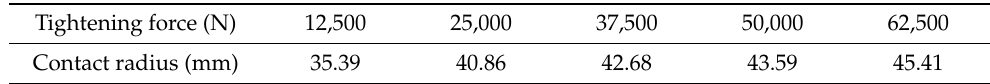
Table 1. The contact radius under different tightening